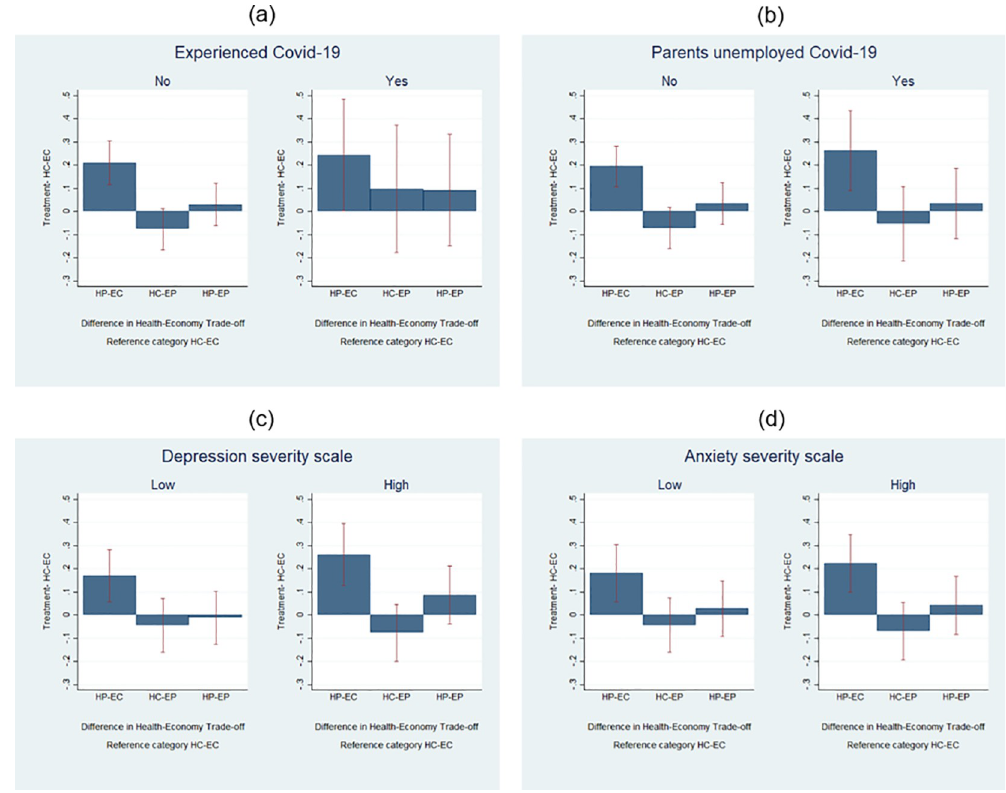
Fig 4. Covid-19 health and economic